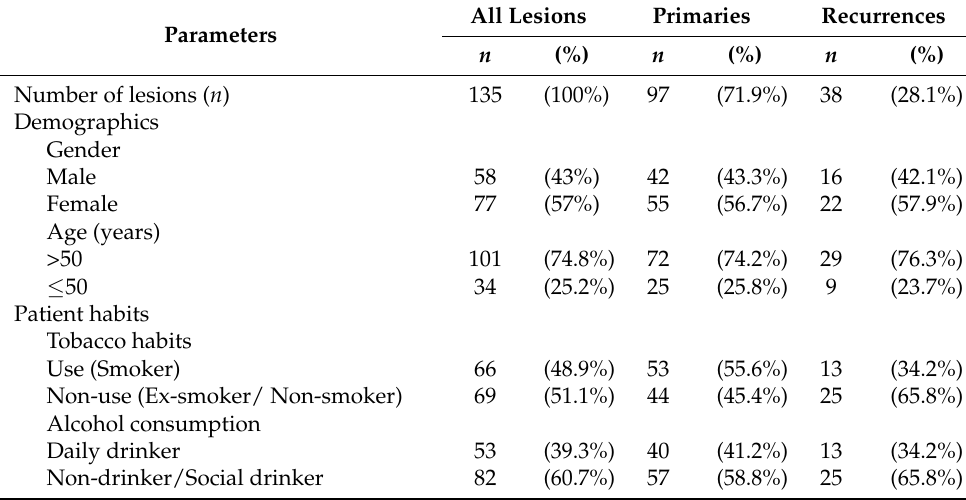
Table 1. Frequency distribution of demographics, tobacco and alcohol habits, and clinical and histopathologic parameters of 135 oral leukoplakia (OL) lesions, including primary lesions and